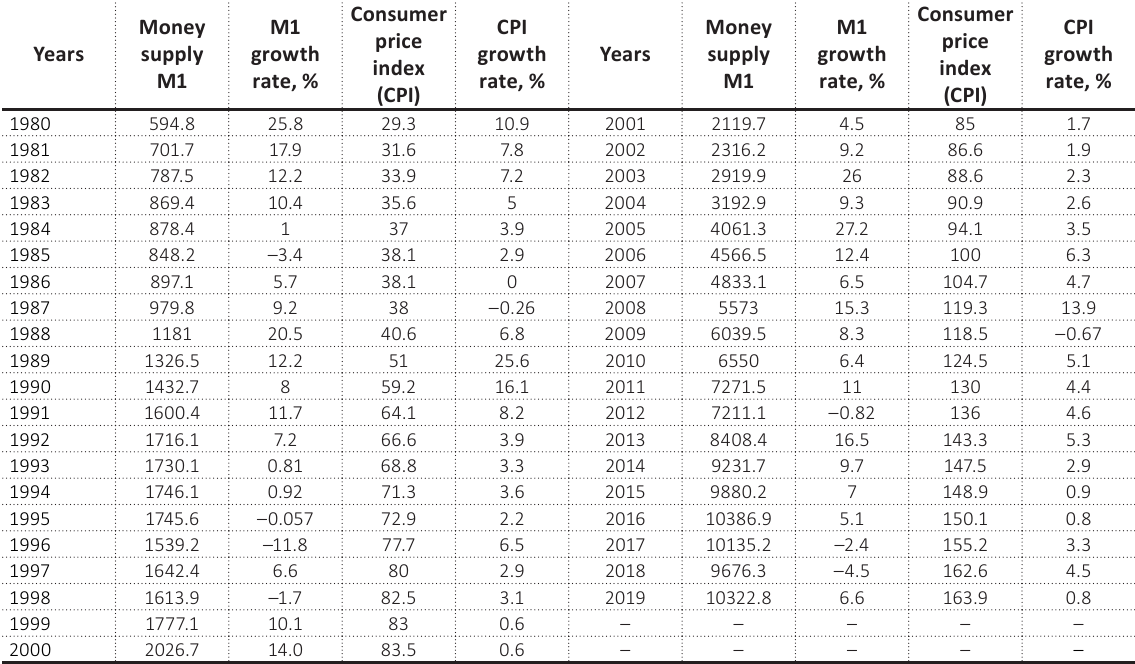
Table 2. Average growth of the study variables divided into four periods